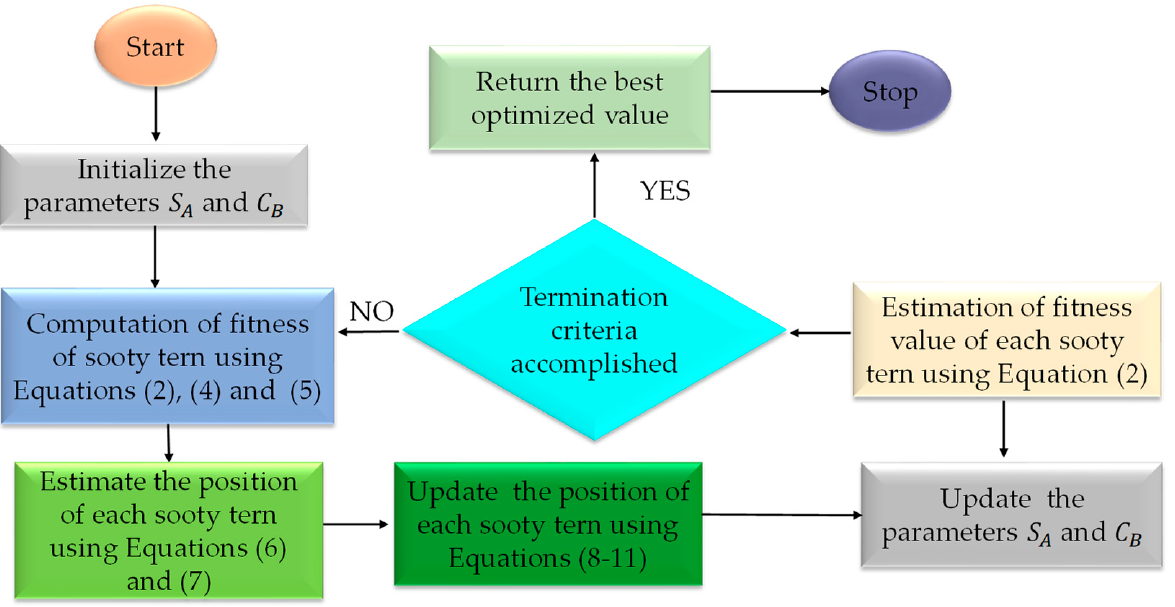
Figure 2. Process flowchart of STO algorithm for parameter estimation of PV cell/module.